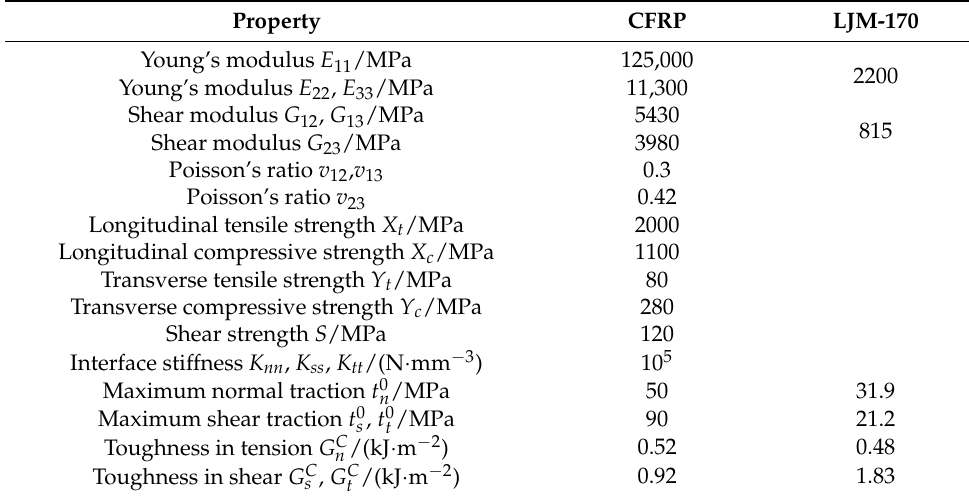
Table 1. Mechanical properties of T300/7901 carbon fiber/epoxy resin composite laminate and adhesive film